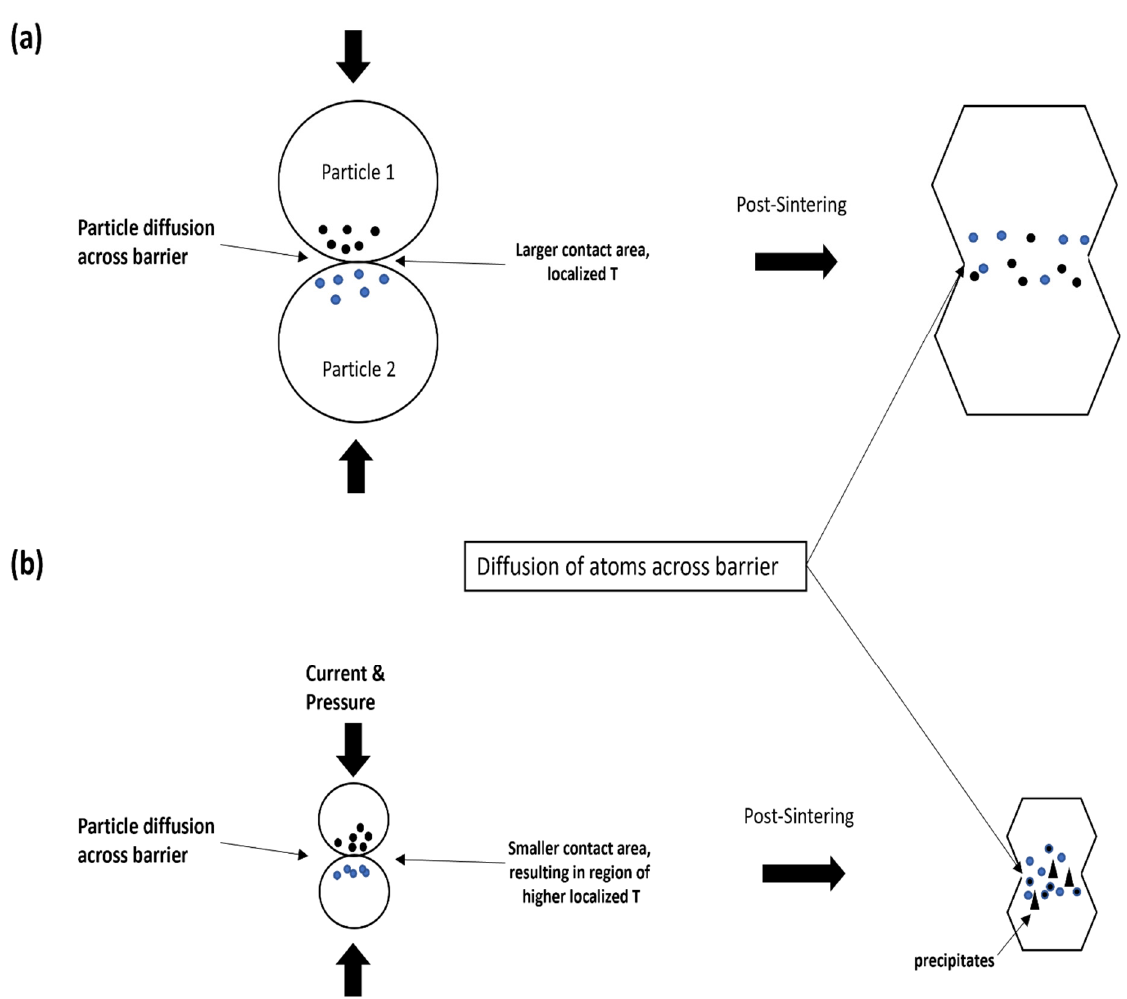
Figure 9. Schematic illustration of the compaction mechanism via SPS of ( a ) larger particles as compared to ( b ) finer particles.